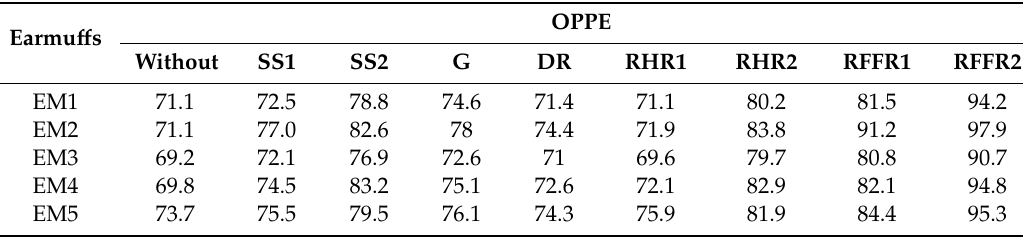
Table 1. L Aeq values determined under earmu ff s used without OPPE and in combination with OPPE. EM—earmu ff s, SS—safety spectacles, G—goggles, DR—disposable respirator, RHR—reusable half